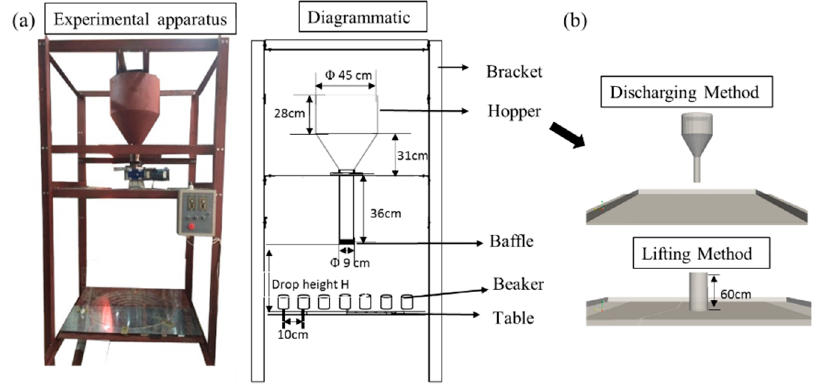
Figure 1. ( a ) Experimental apparatus and schematic of the measurement of pellet pile and ( b ) the geometric models of different packing method in simulation.